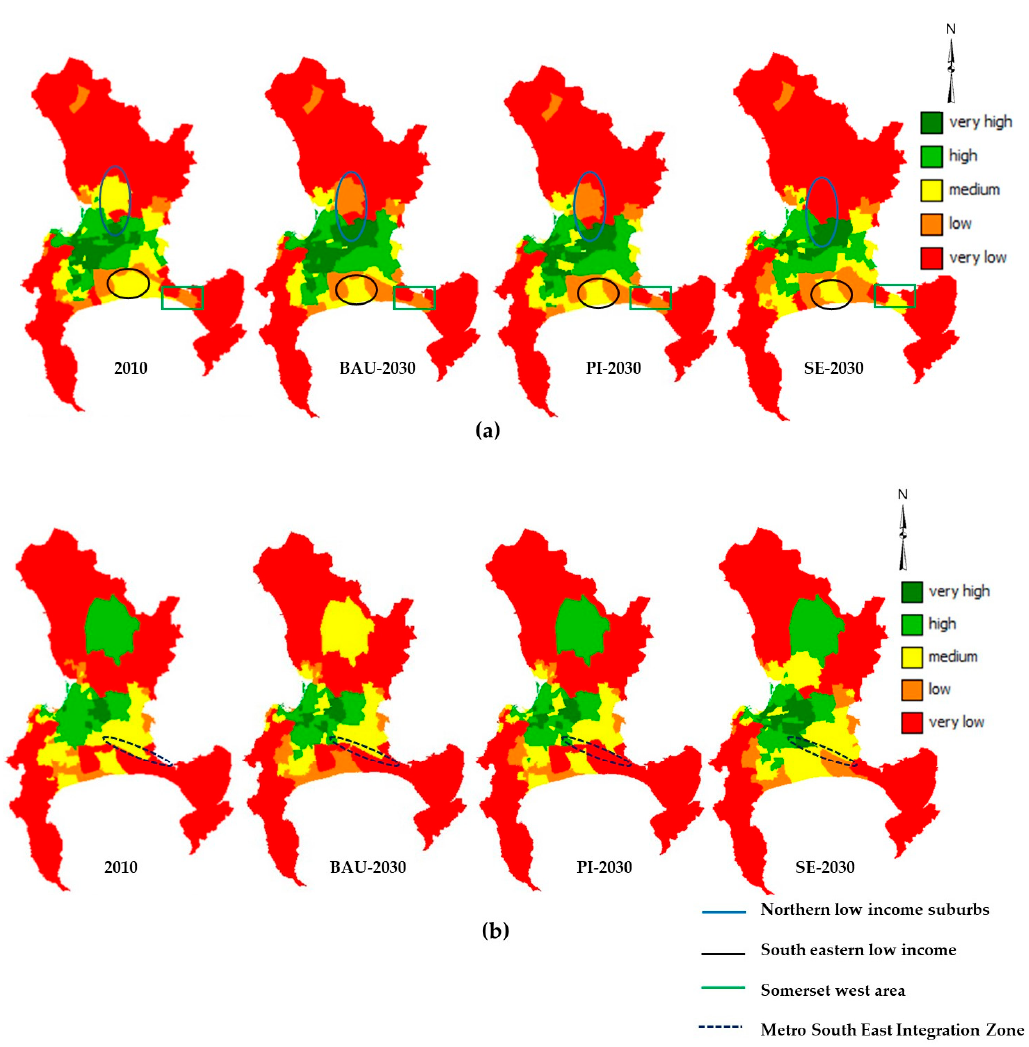
Figure 9. Comparison of the Zonal accessibility for; ( a ) manufacturing; ( b ) trade and services in 2030 under different scenarios as well as 2010 .